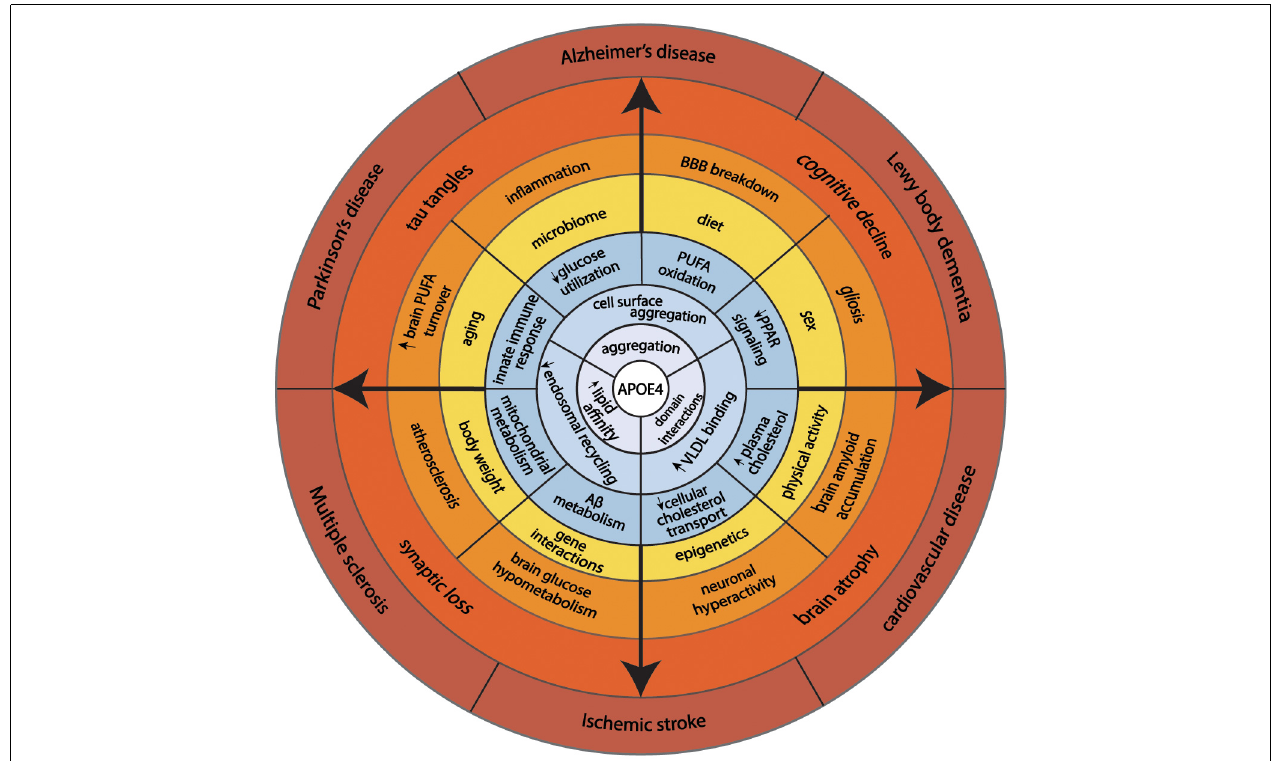
FIGURE 2 | This model illustrates how fundamental structural properties of apoE4 (domain-interactions, greater affinity to lipid binding, and self-aggregation) alter cellular biology promoting endosomal congestion, cell surface aggregation with other proteins, and association with larger lipid-containing particles in the circulation. These biochemical features associated with changes in cellular energy preferences, cholesterol transport, immune response, and A β metabolism. Complex interaction with aging, sex, diet, physical activity, and genetics predispose APOE4 carriers to aging-associated